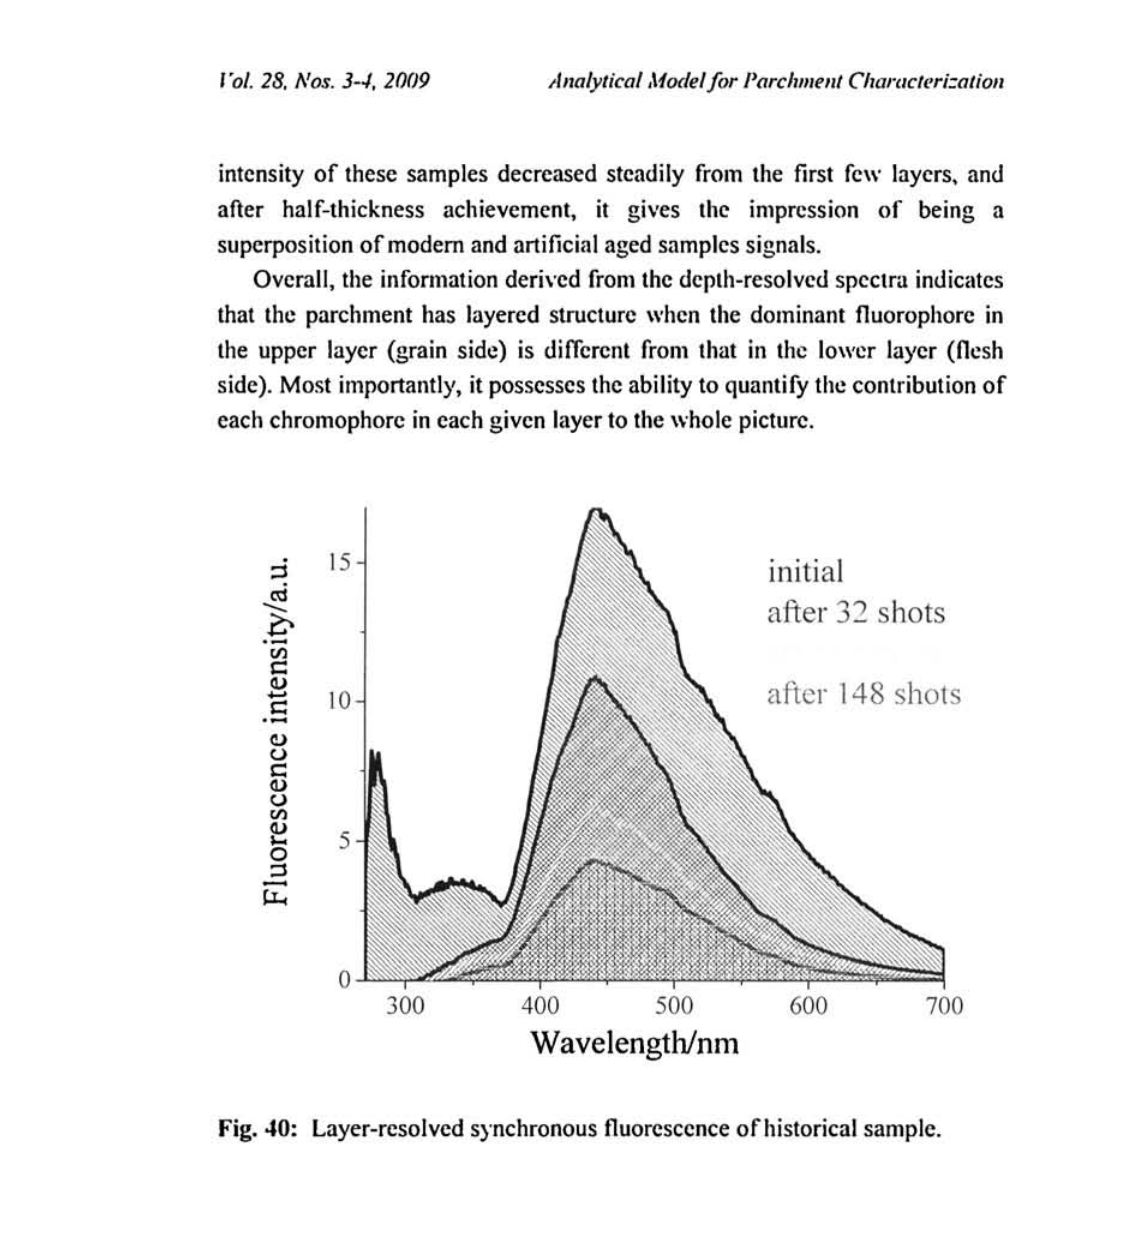
Fig. 40: Layer-resolved synchronous fluorescence of historical sample.